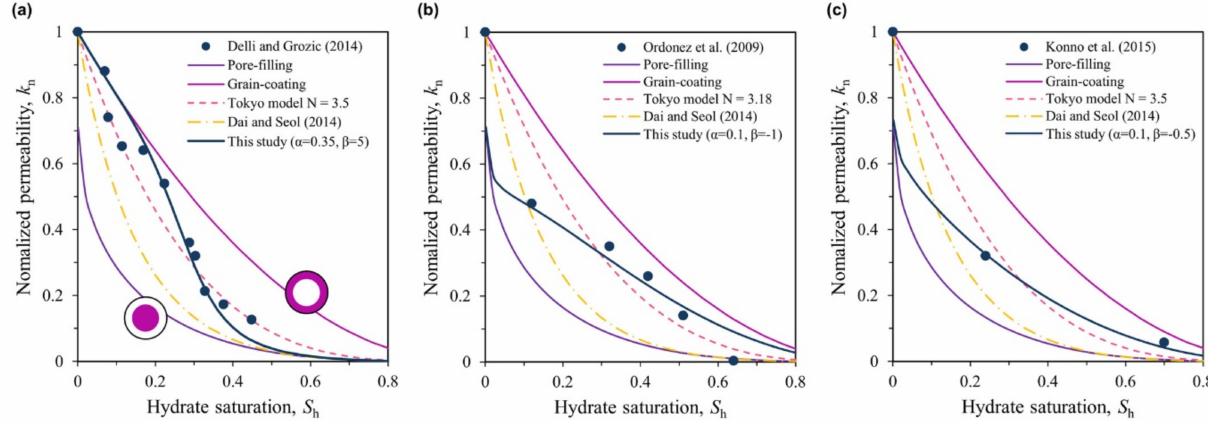
Figure 35. Permeability evolution in hydrate-bearing sediments with hydrate formed under different conditions. ( a ) Experimental results from excess-gas method [24]; ( b ) experimental results from excess-water method [112]; ( c ) experimental results from dissolved-gas method [114]. The adopted existing analytical models are from literatures [23,40,42]. Reprinted with permission from Ref. [68]. Copyright 2022 American Geophysical